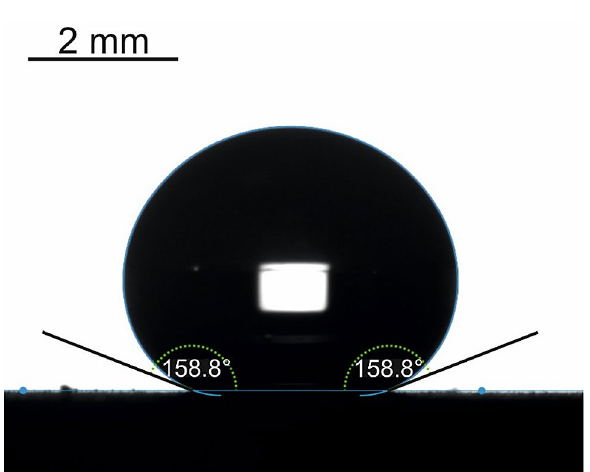
Figure 7. 5 μl DMSO droplet placed on the “urchin”-like fluorinated surface is shown. Apparent contact angle is θ = 158.8 ± 1 ◦ , the sliding angle was 15°.